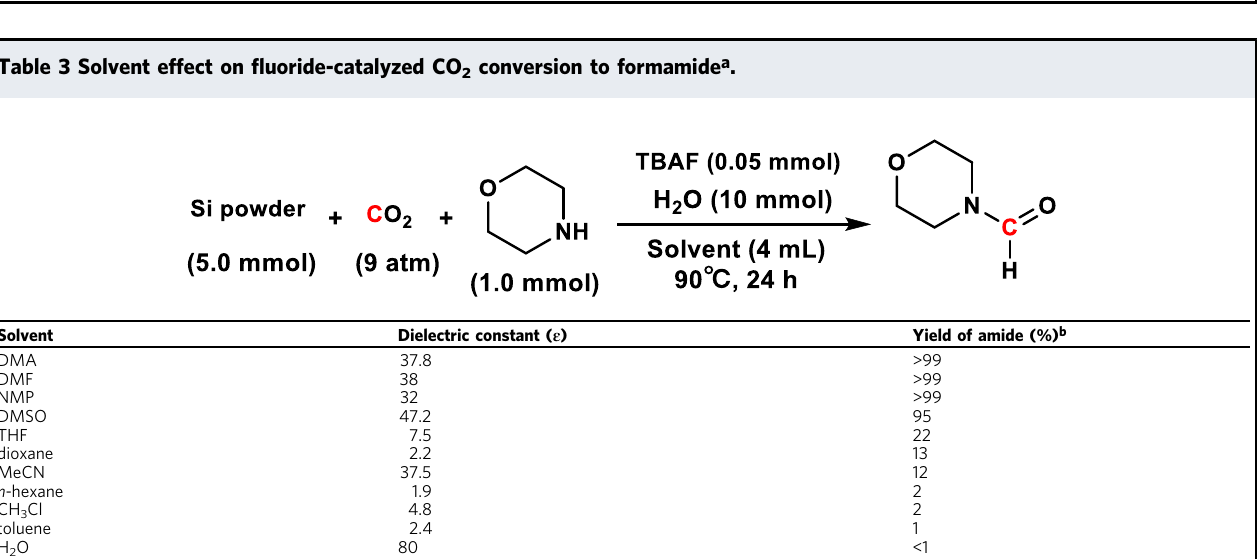
Solvent Dielectric constant ( ε